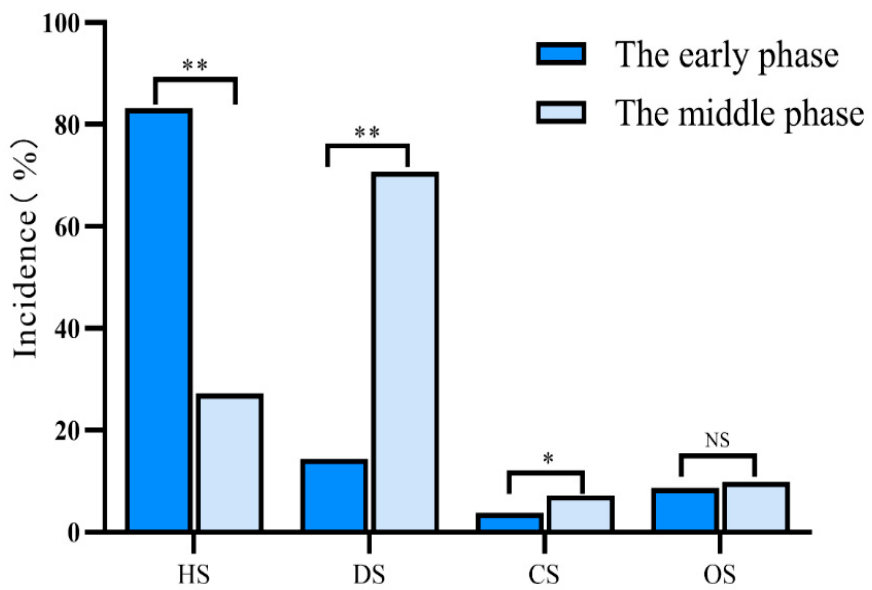
Figure 2. Incidence of different types of shock in polytrauma patients. The early phase was defined as the period of ≤ 48 h after polytrauma and the middle phase was defined as the period between 48 h and 14 days. HS: hypovolemic shock; DS: distributive shock; CS: cardiogenic shock; OS: obstruc- tive shock; * p < 0.05; ** p < 0.01; NS: not statistically